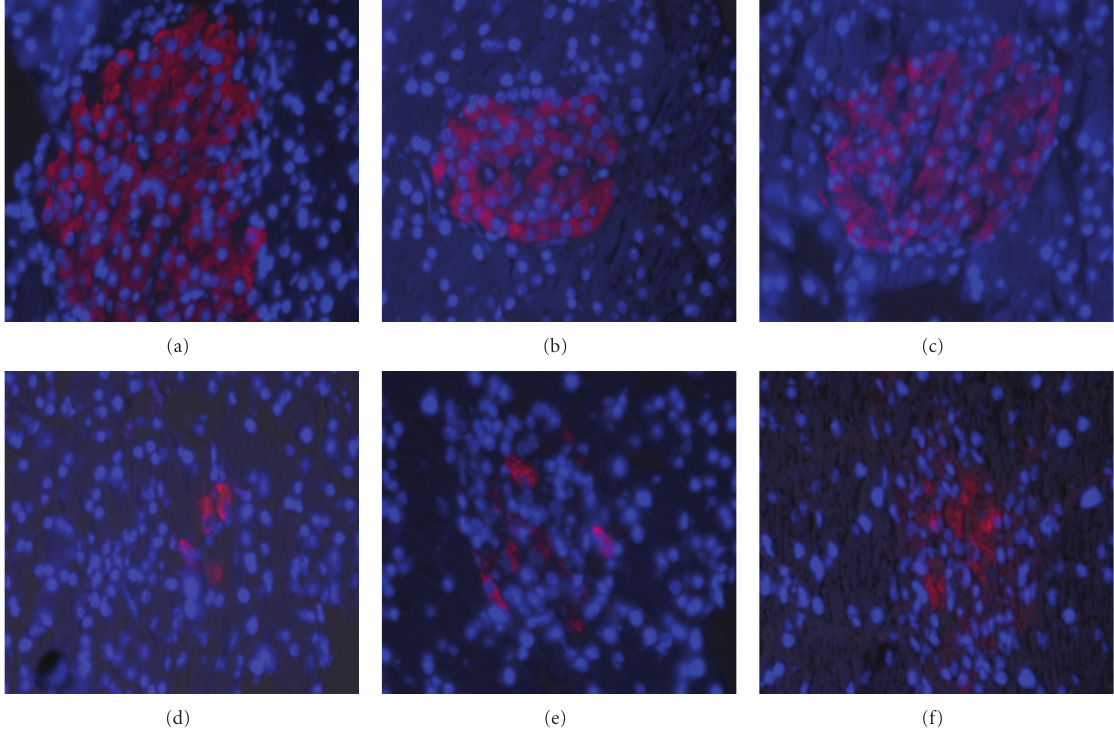
Figure 9: Detection of apoptotic β -cells by the TUNEL technique in insulin-stained pancreatic islet cells from NF (a, d), IF (b, e), and CR (c, f) control (a, b, c) and STZ (d, e, f)